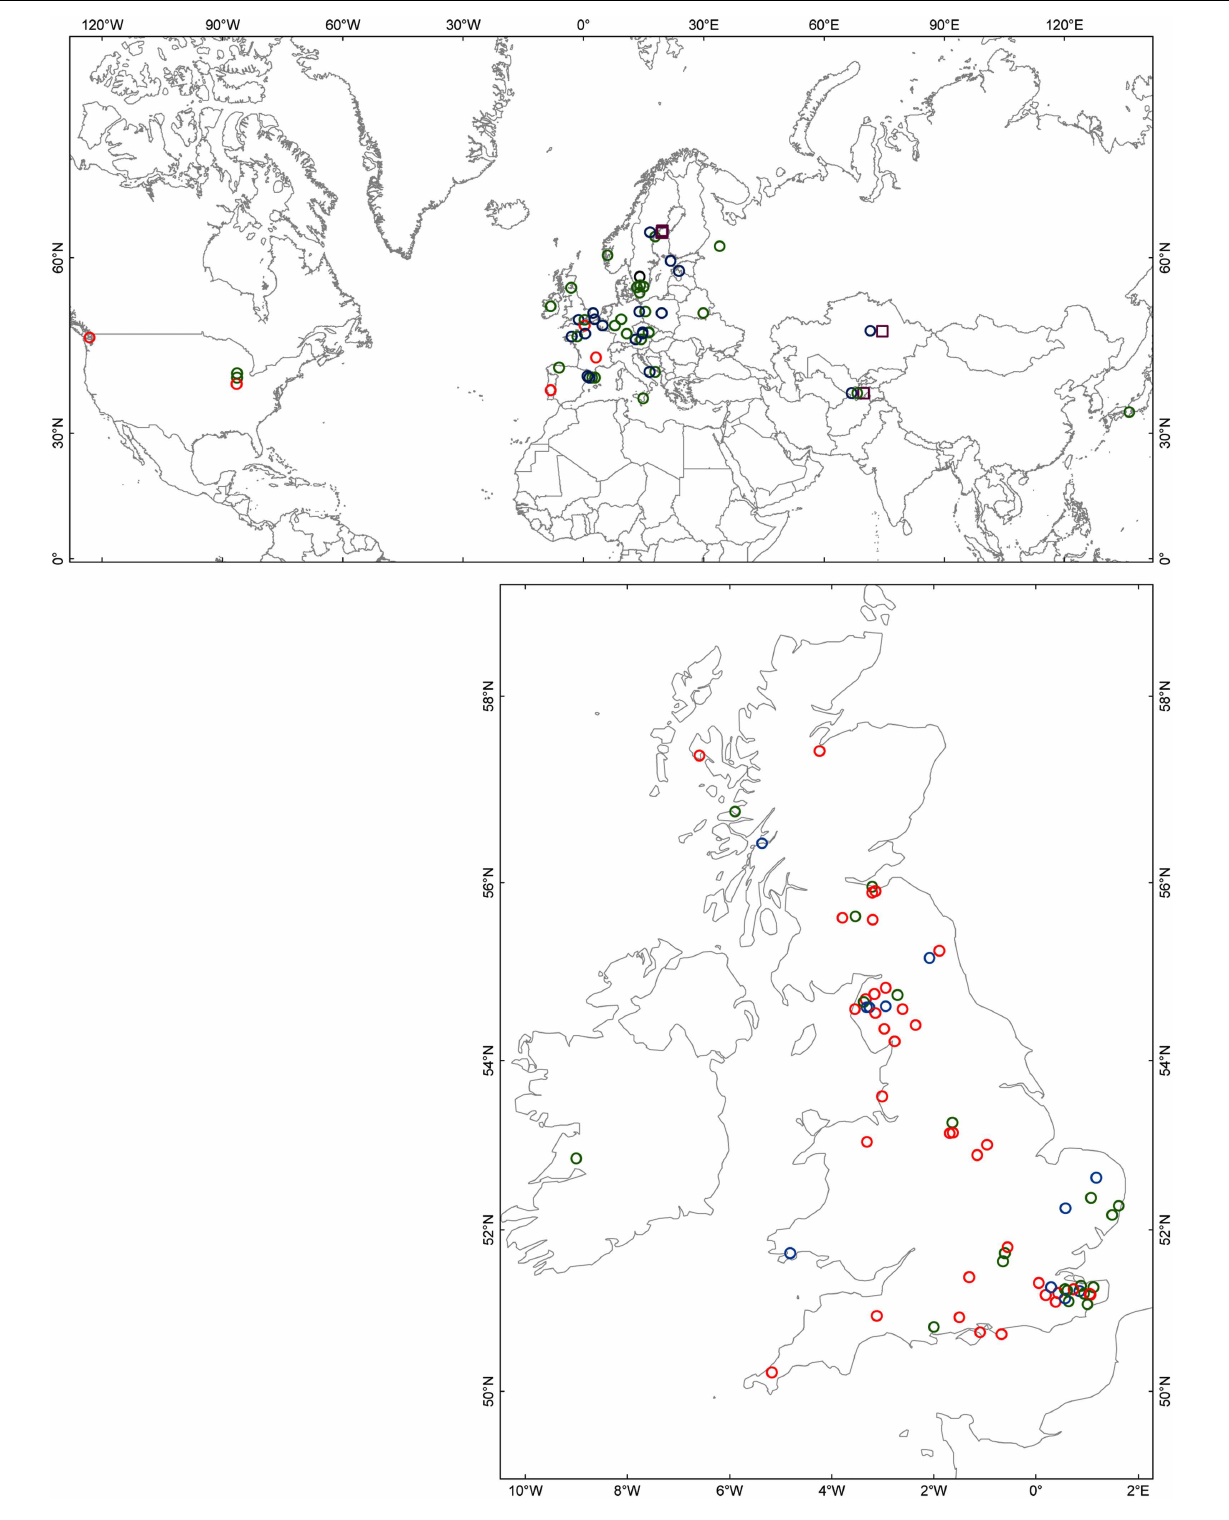
FIGUREA1 | Geographical distribution of phenotyped accessions in which genotypes have been defined based on the diagnostic CAPs markers. Accessions with the I 149 D 150 D 151 deletion (CAPs marker 1) and the G 703 > W 703 (CAPs marker 2) are represented by open red circles; presence of only CAPs marker 1 by open green circles; presence of only CAPs marker 2